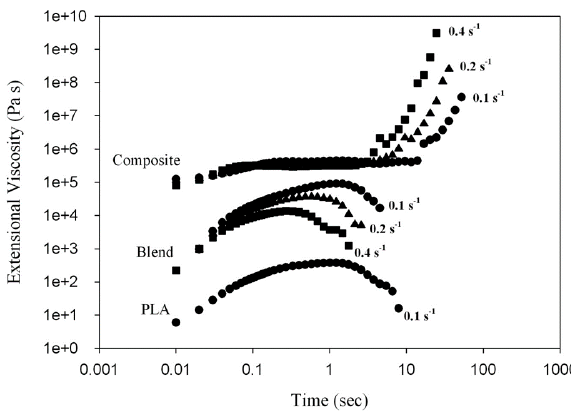
Figure 5. Time-dependence of the tensile stress growth coe ffi cient, η + PLA / PHA blend and in situ generated